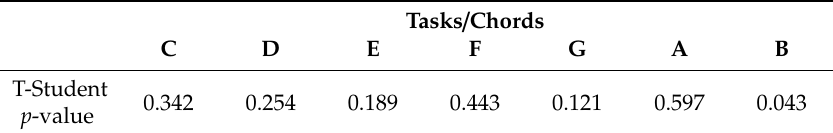
Table 3. p -Value obtained upon performing t-students analysis to compare mean time of tasks by methodology